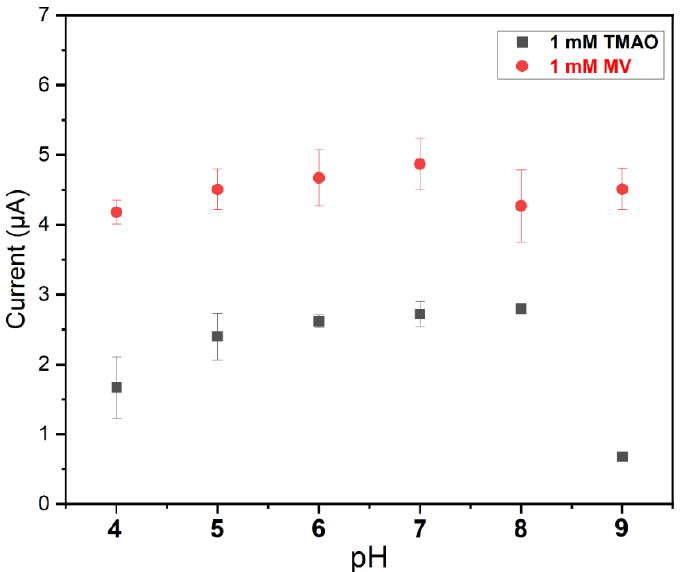
Figure 6. pH dependency of the response of the TorA biosensor to (red) mediator and (black) TMAO. TorA (5.9 nmol/cm 2 ) GOD 10 U, Cat 1000 U, 3 mM glucose, PVA 3%. Measurements were performed in Sörensen phosphate buffer with different pH values (5, 6, 7 and 8) and containing 3 mM glucose. Solutions used to perform experiments at pH 4 and pH 9 were obtained by adding a solution of HCl (100 mM) and NaOH (100 mM), respectively, to the previous Sörensen phosphate buffer (67 mM) containing 1 M KCl (n = 9, 3 electrodes) .